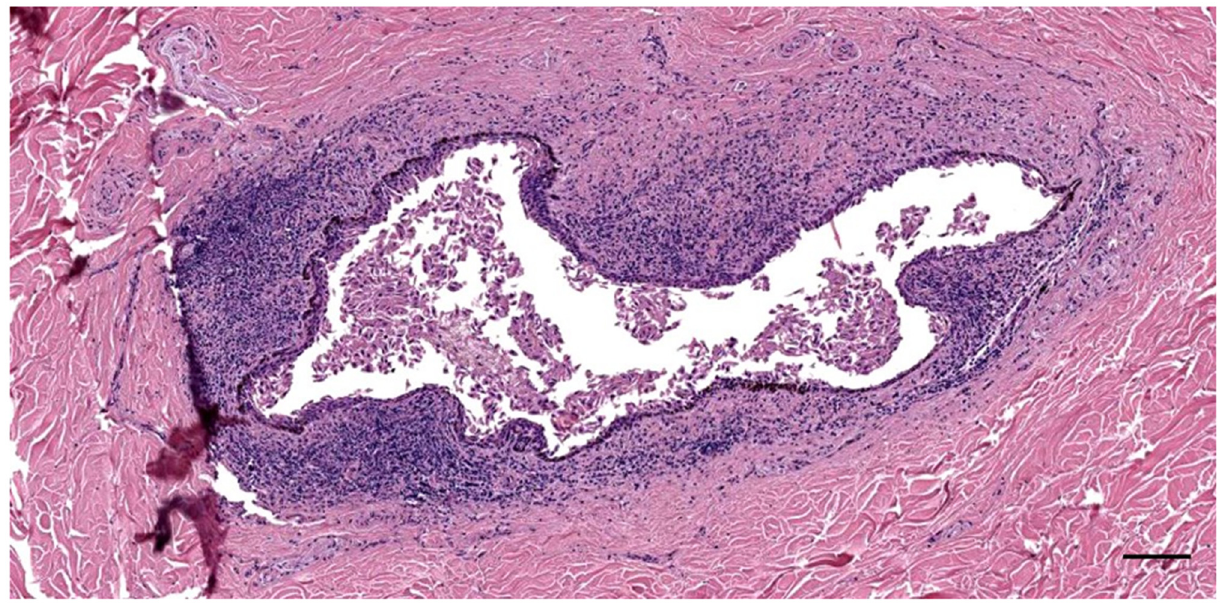
Figure A2. A histological image (HE staining) of an oblique section through the external ear canal (1) of a striped dolphin (293/18) at the level of the ventral curvature of the canal and glands (2). Note the intense circummeatal presence of inflammatory cells (3) with ulceration of the epithelium (4), and the presence of lamellar corpuscles (5). Scale bar = 100 µm.